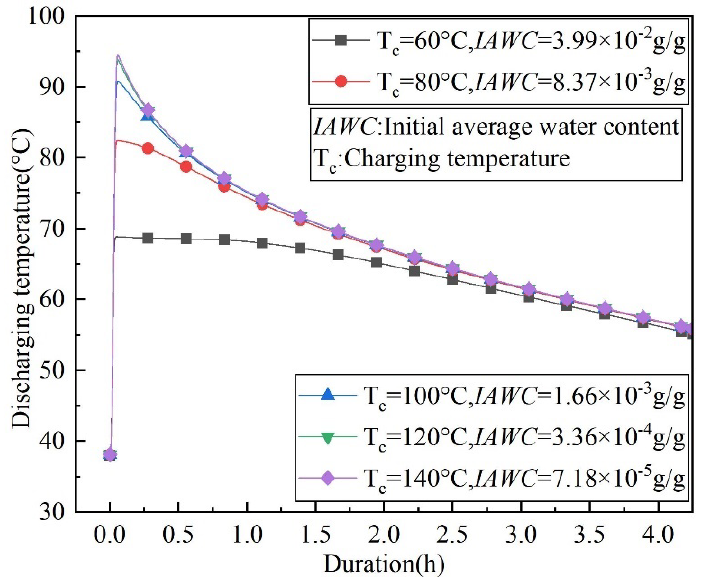
Figure 12. Change in air outlet temperature with time in discharging process under different charging temperatures (mass fraction of water vapor in charging process is 1.45%).